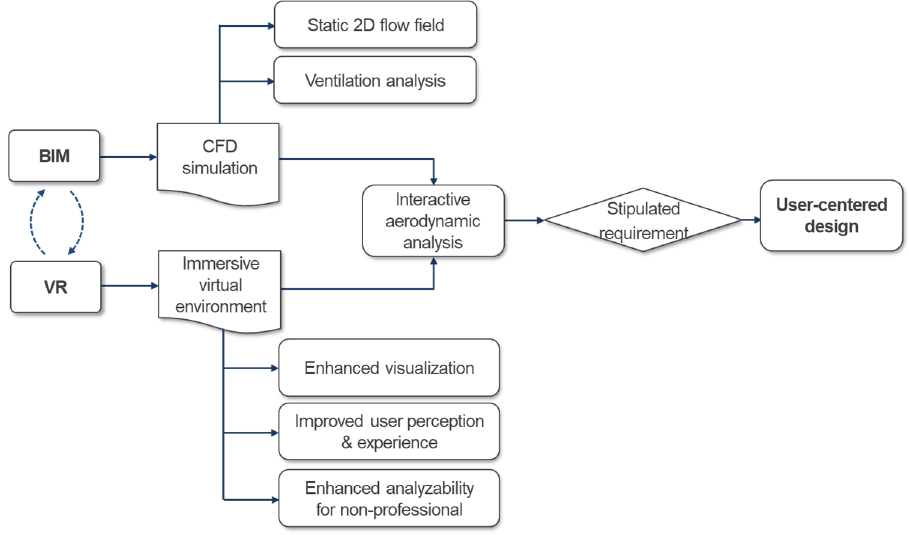
Figure 17. Analysis framework for BIM and VR enhancement design.